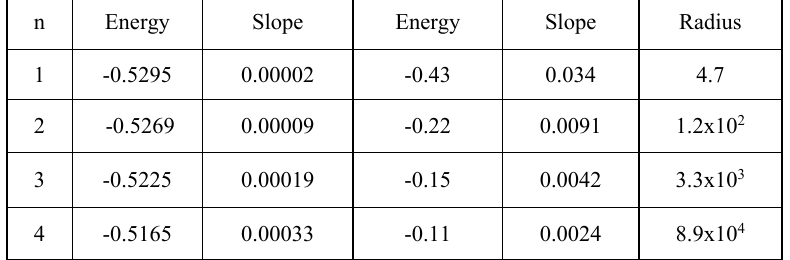
Table 2. Numerical result for Wilsonian regulator with IR cutoff k = 1.0: the first two Columns are for the eigenvalues, slopes with fixed coupling constant and the last with running-coupling